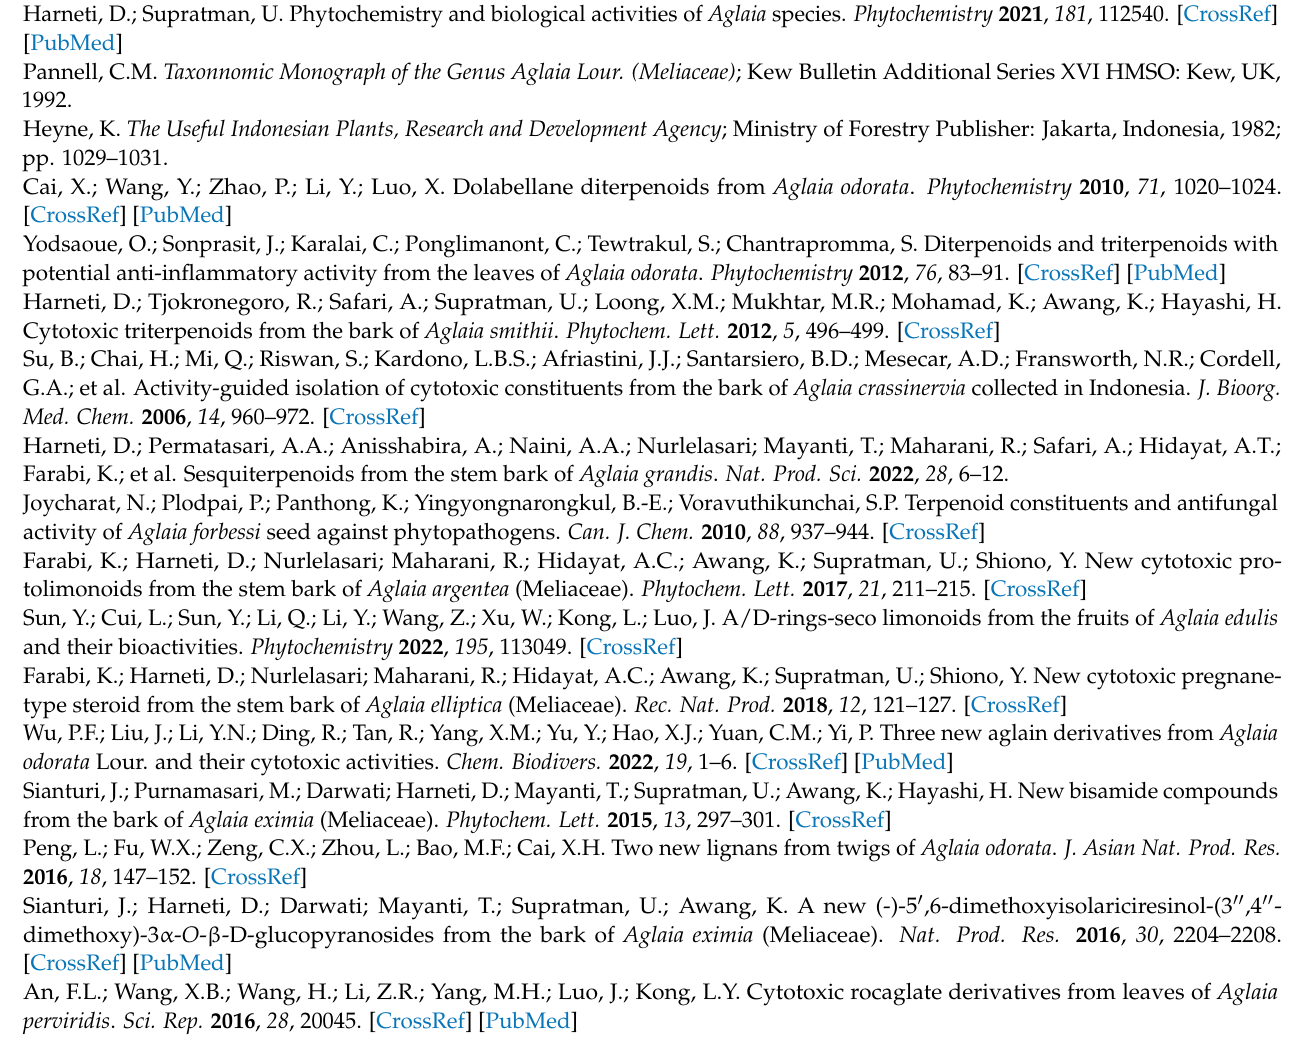
cell line; Figure S27. Results of cytotoxic activity of 4 against B16-F10 cell line; Figure S28. Results of cytotoxic activity of 5 against B16-F10 cell